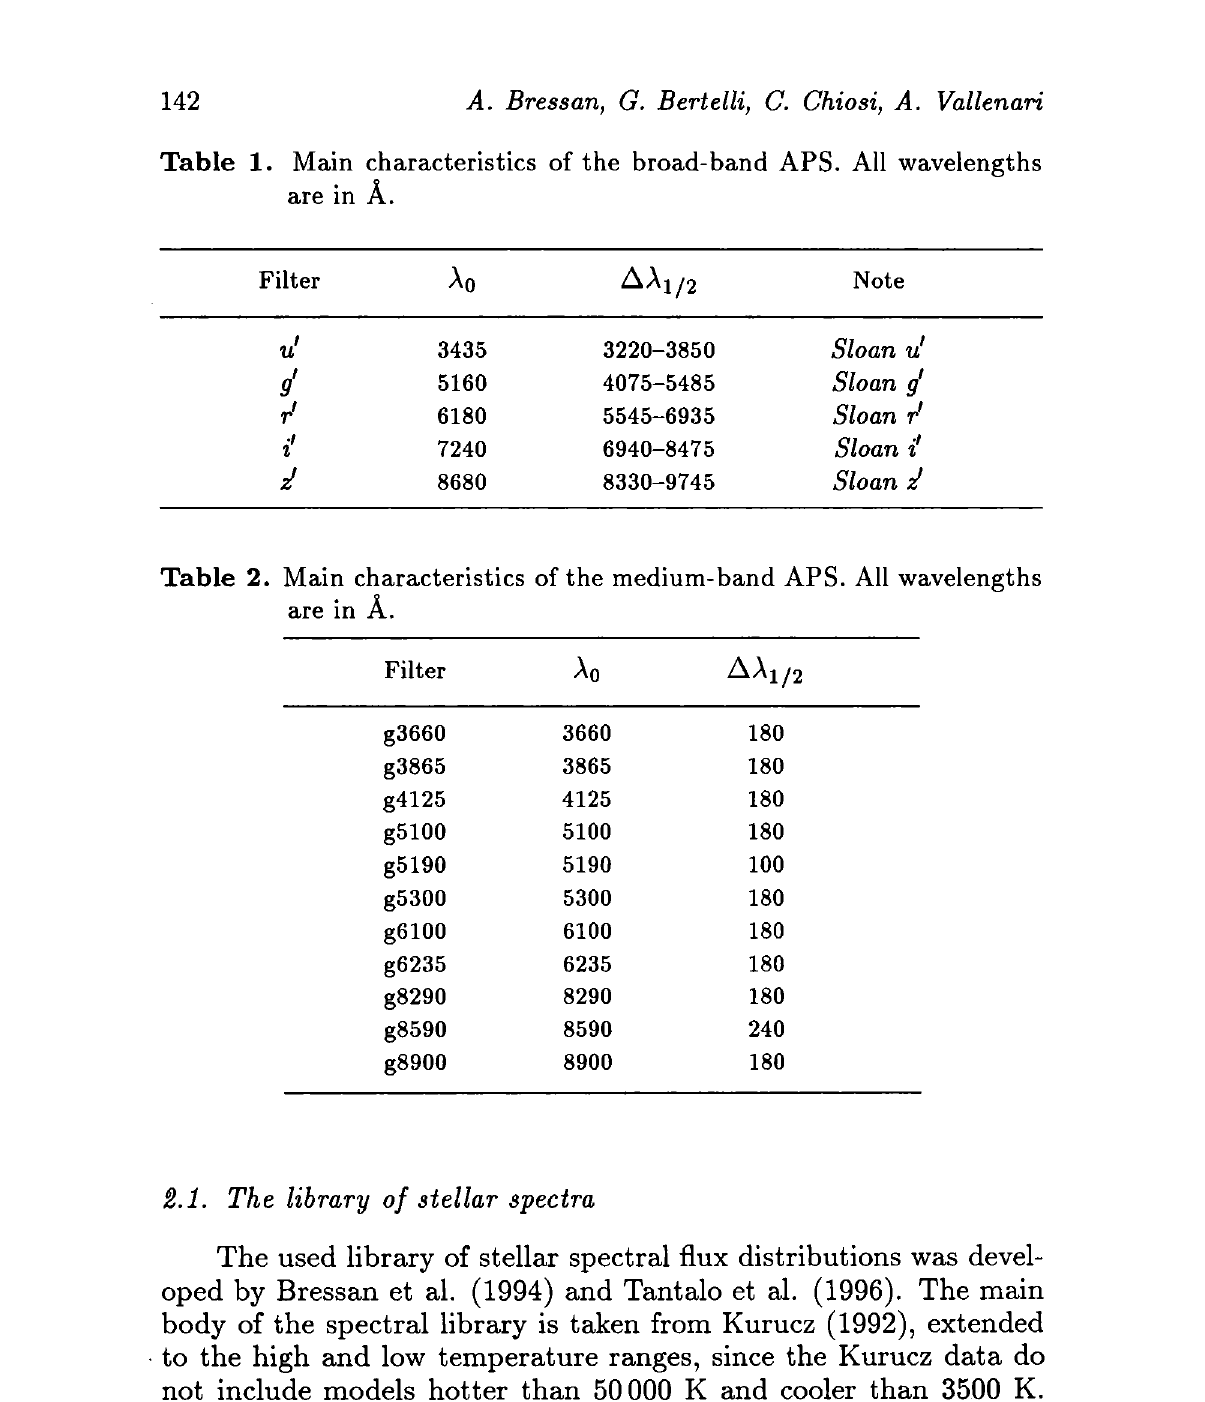
Table 1. Main characteristics of the broad-band APS. All wavelengths are in Á.